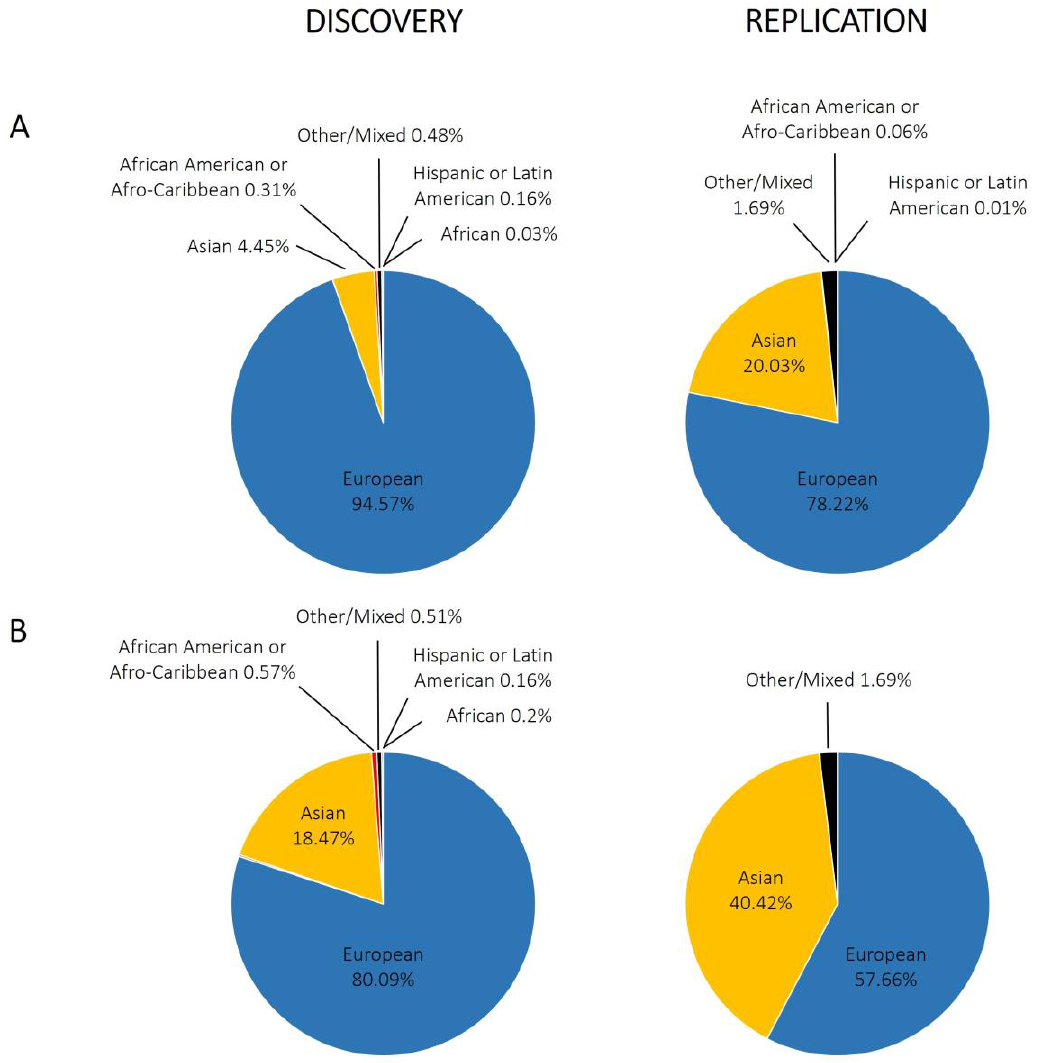
Figure 3. Representation of di ff erent ethnic groups in genome-wide association studies performed in the rheumatic disorders. ( A ) Combining di ff erent rheumatic disorders: rheumatoid arthritis, systemic lupus erythematosus, osteoarthritis, ankylosing spondylitis, psoriatic arthritis, and Behçet’s disease; ( B ) only rheumatoid arthritis.